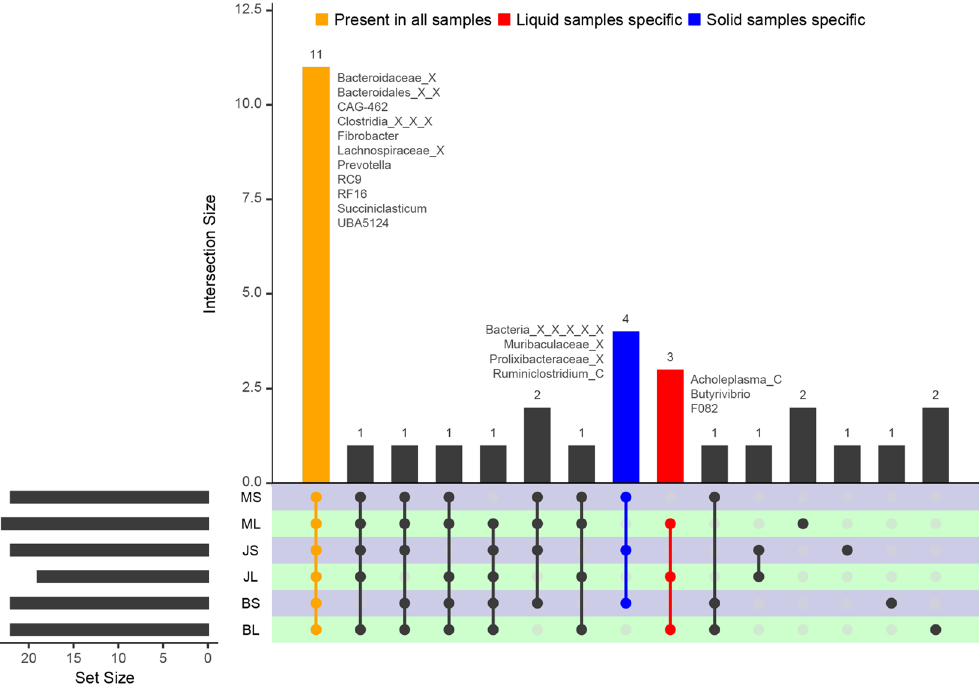
Figure 4. UpSet plot showing intersections among six groups of three feed and two fractions. Bars colored in Yellow, Blue and Red shows genus/taxa exclusively observed in all groups, Solid samples and Liquid samples, respectively. The names of taxa in colored bars are mentioned besides the